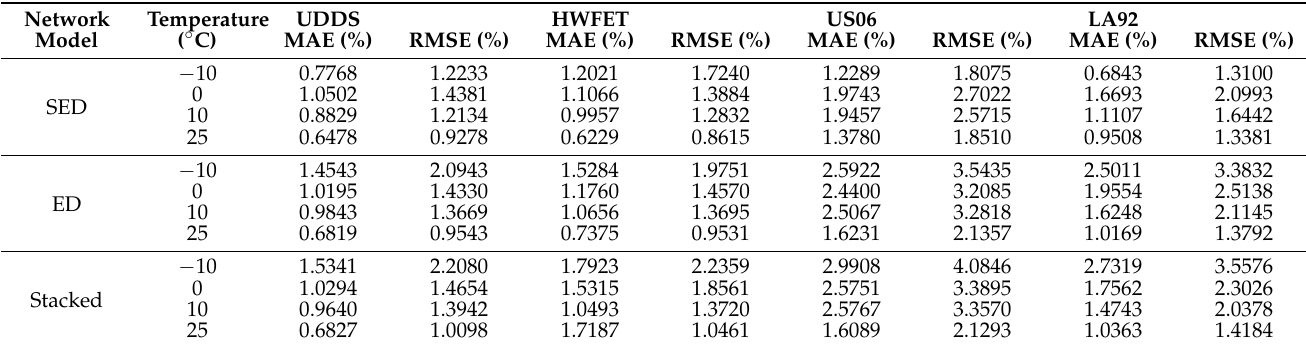
Table 3. Performance metrics at different